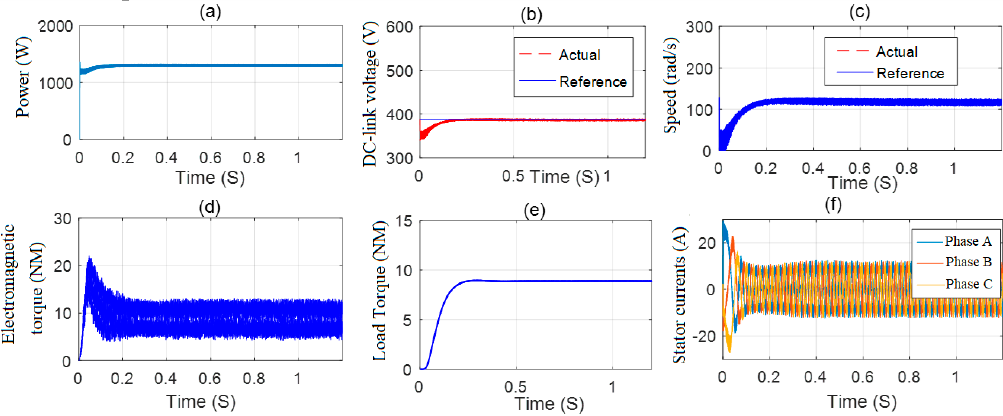
Figure 9. Performance of SPVWPS under partial shading condition using COA algorithm tuned PI controller of the DC link voltage and rotor speed. ( a ) power; ( b ) DC voltage; ( c ) speed; ( d ) electromagnetic torque; ( e ) load torque and ( f ) stator currents.